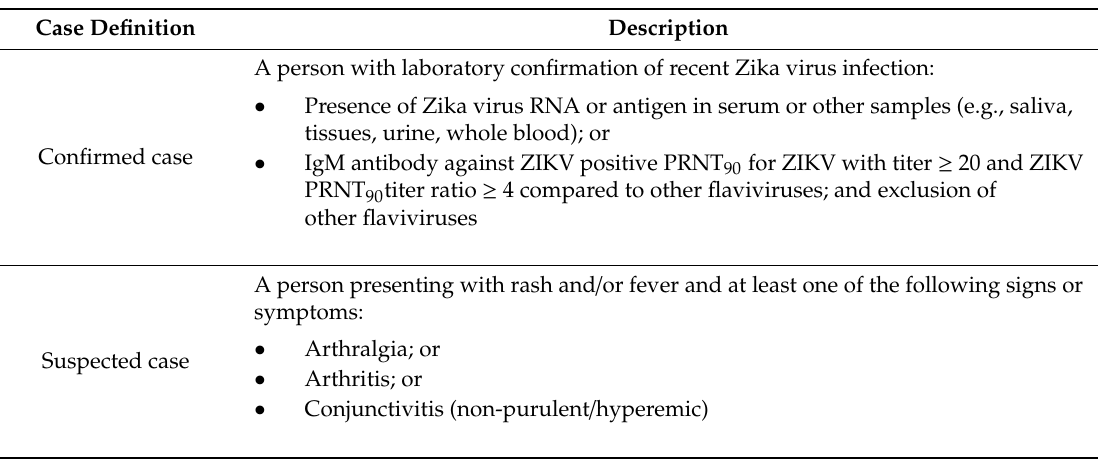
Table 1. WHO 2016 interim case definitions for confirmed and suspected Zika virus